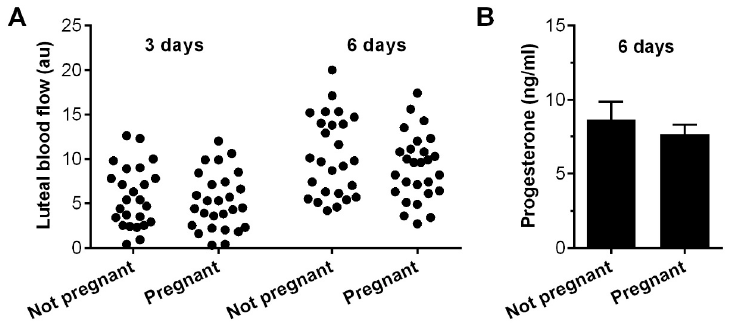
Figure 3. Luteal blood flow, progesterone concentrations, and per cycle pregnancy rate. ( A ) Dot plot of blood flow 3 and 6 days after ovulation for cases that did not conceive (n = 26) compared with cases that resulted in pregnancy (n = 27). ( B ) Plasma progesterone concentrations 6 days after ovulation for cases that did not conceive (n = 26) compared with cases that resulted in pregnancy (n = 27). Data are presented as mean (SEM).